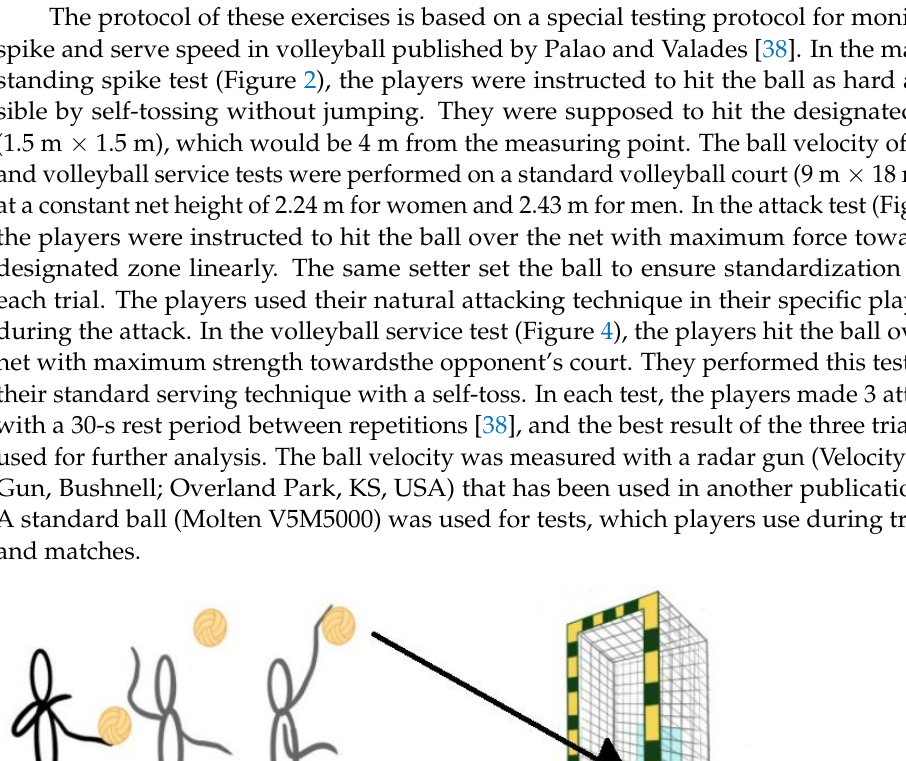
Figure 3. The attack test. Figure 4. The volleyball service test. 2.7. Volleyball Specific-Skills Assessment Volleyball skills were assessed in terms of the accuracy of the attack and the service. These tests were performed on a standard volleyball court (9 m × 18 m) and at a constant net height of 2.24 m for women and 2.43 m for men. A modified test designed to stand-